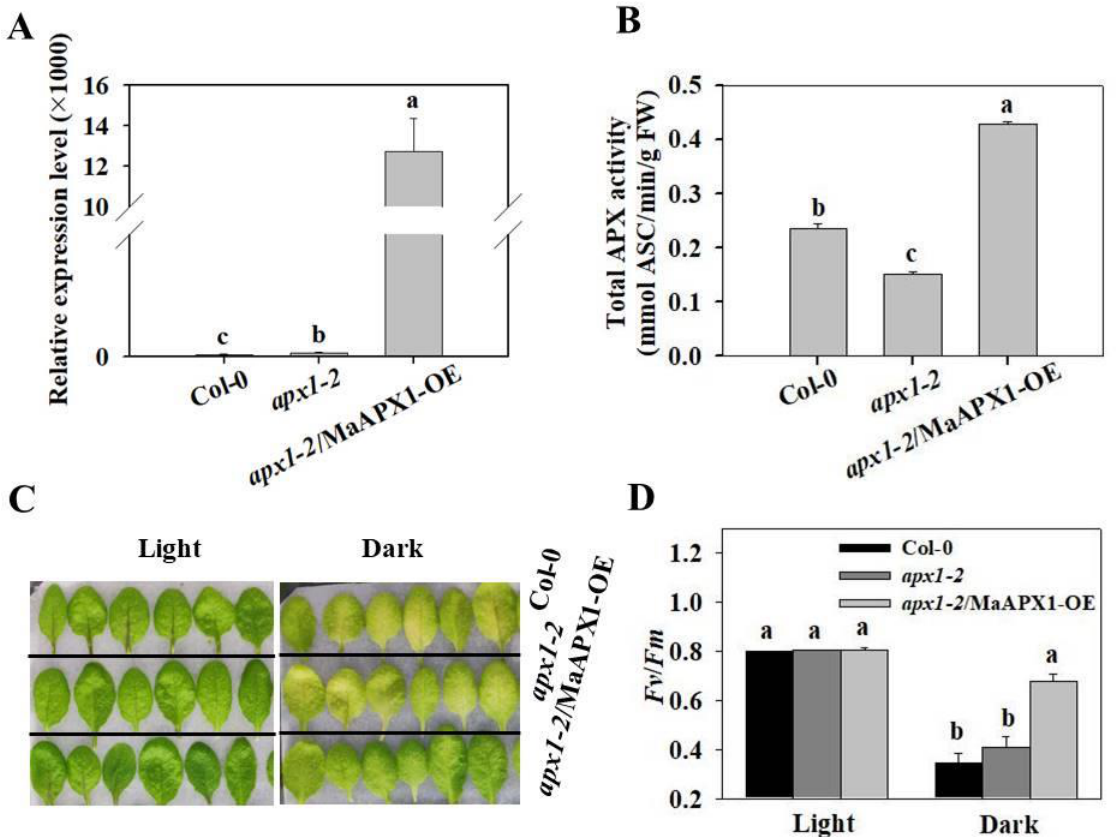
2 Figure 2. Ectopic overexpression of MaAPX1 delays the detached leave senescence induced by darkness in Arabidopsis. ( A ) Expression of MaAPX1 in Col-0, apx1-2, and apx1-2 /MaAPX1-OE seedlings. ( B ) Total APX activity in Col-0, apx1-2, and apx1-2 /MaAPX1-OE seedlings. ( C , D ) Phenotype and Fv/Fm of detached leaves from three different genotypes incubated under dark or light (control) conditions for 5 d. Different letters above the bars indicate statistically significant differences between the samples (Student’s t test; p <